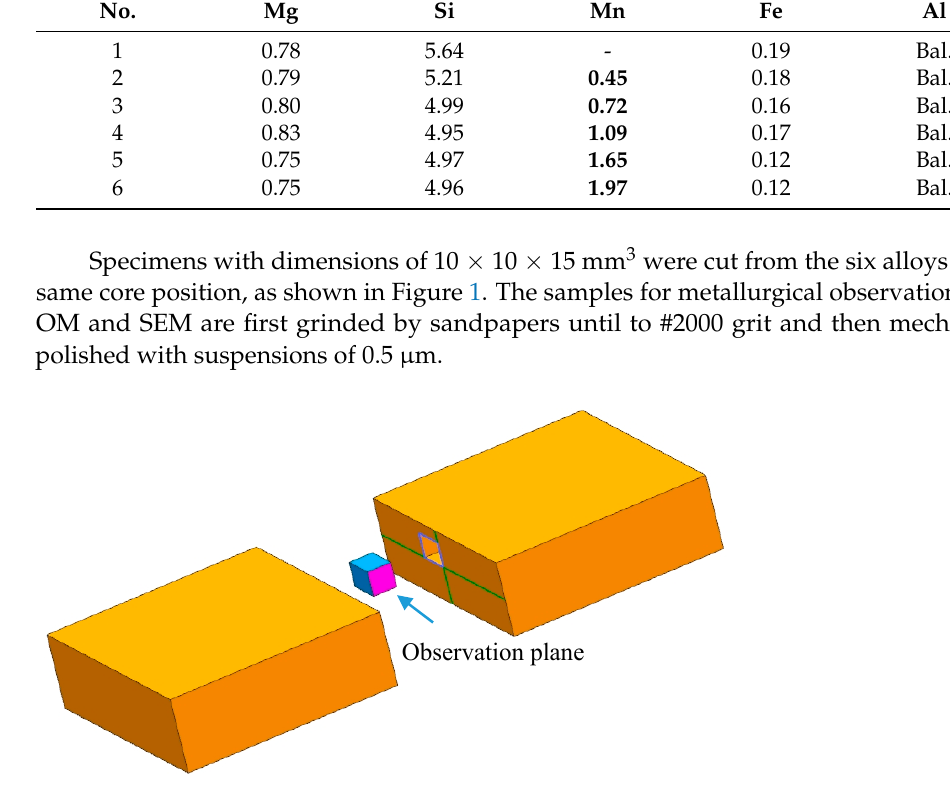
Table 1. Compositions of the alloy ingots in the present study (mass %).